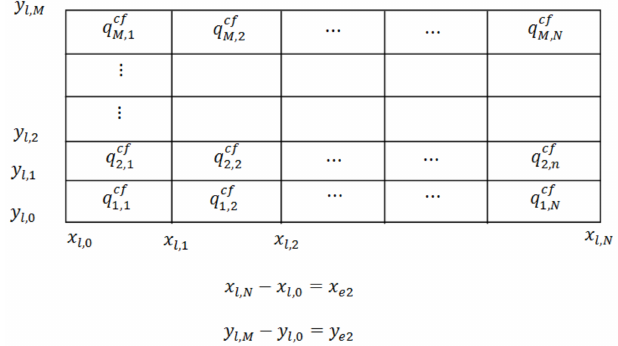
Figure 5. Division of the inter-layer pure-plane